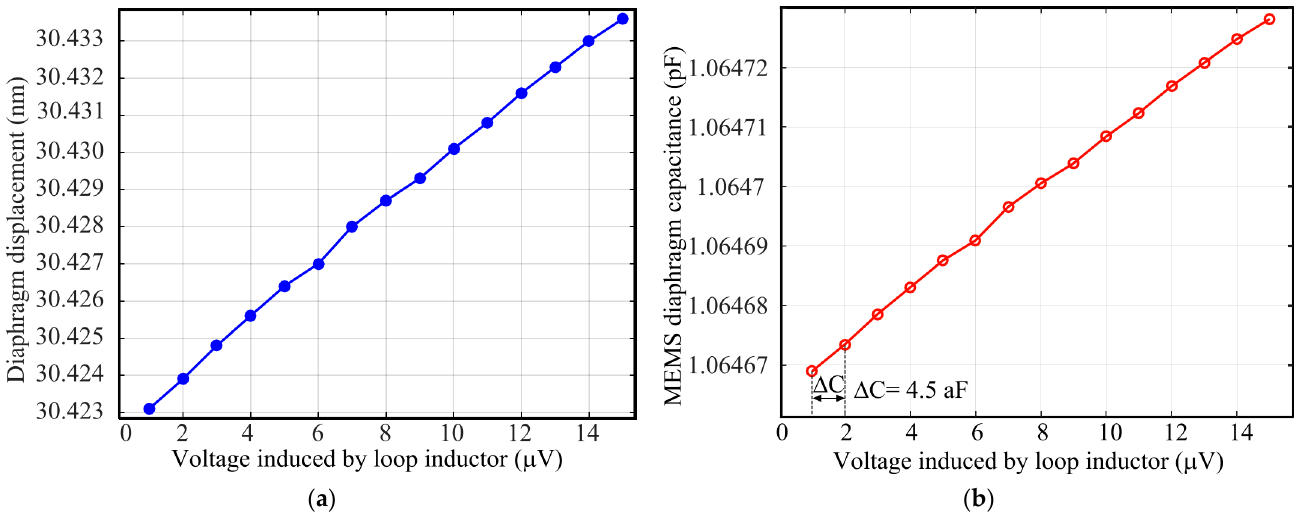
Figure 11. ( a ) 3D FEA simulated diaphragm deflection; ( b ) 3D FEA simulated capacitance change due to the induced voltage.